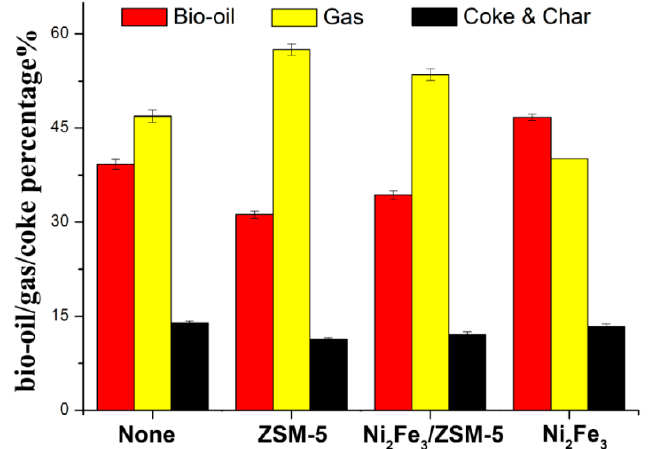
Figure 3. Bio-oil, gas, and char / coke yields from the pyrolysis of cellulose without / with the ZSM-5, Ni 2 Fe 3 / ZSM-5, and Ni 2 Fe 3 catalysts (homogeneous catalysis) and None: without catalysts. In addition, the thermal conductivity coefficient is different, 0.23 W/m·K for cellulose, 73.3 W/m·K for Ni, 61.6 W/m·K for Fe, and 22.2 W/m·K for Ni 2 Fe 3 mix with cellulose [18,24]. Ni and Fe are